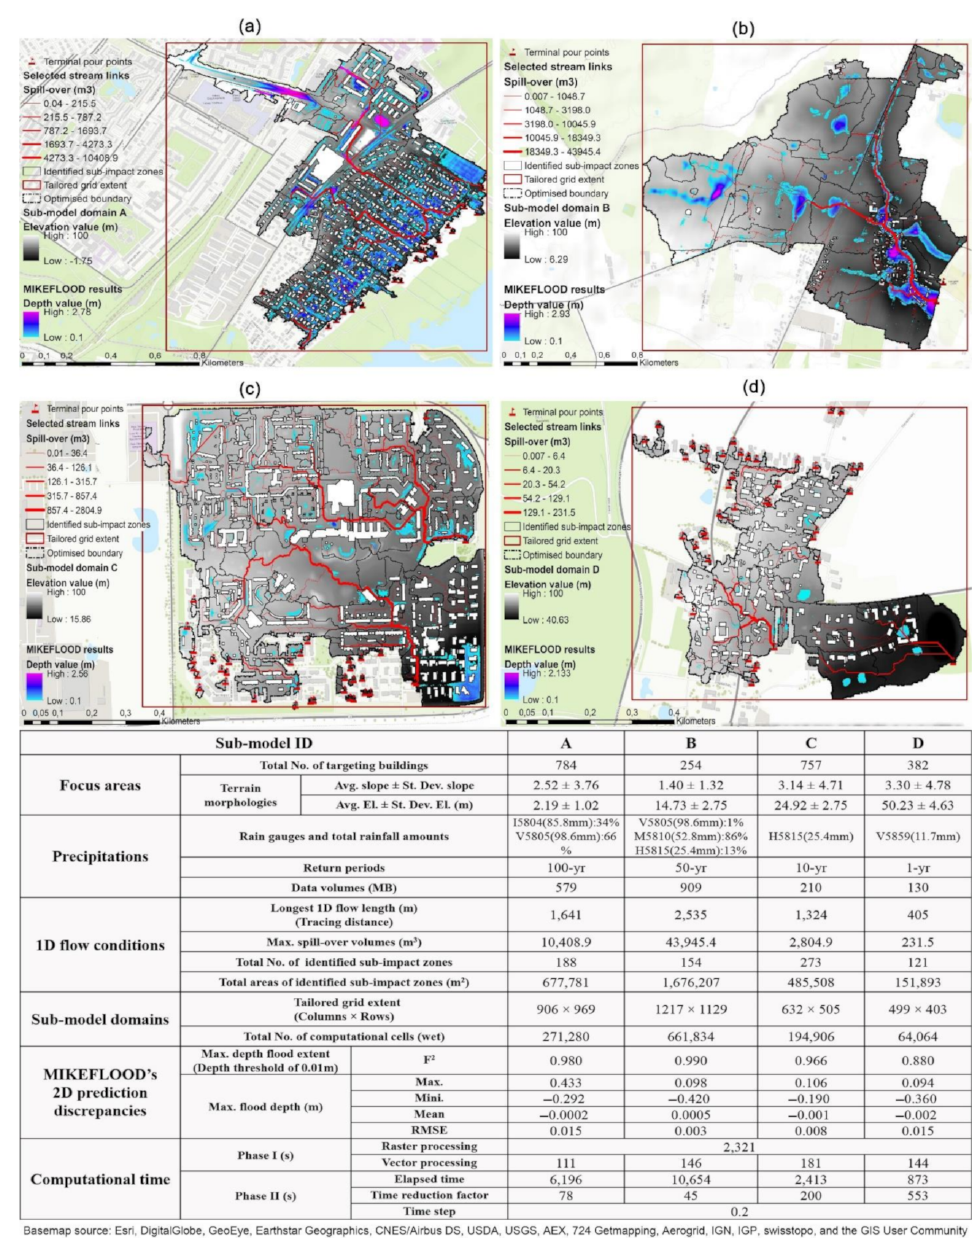
Figure 12. Four sub-models’ 1D flow conditions, identified computational domains and their cor- respondent MIKE FLOOD predictions based on various types of terrain morphologies and rainfall return periods in 1–100 years: ( a ) Sub-model A, ( b ) Sub-model B, ( c ) Sub-model C and ( d ) Sub-model D. The optimised boundary conditions suggested by the sub-model approach are used for four sub-model simulations, where 2D outlets are established at the terminal pour points position that allows for water spilling at the pour point level. The detailed inputs, outputs, prediction validation and computational time information for each sub-model are provided in the